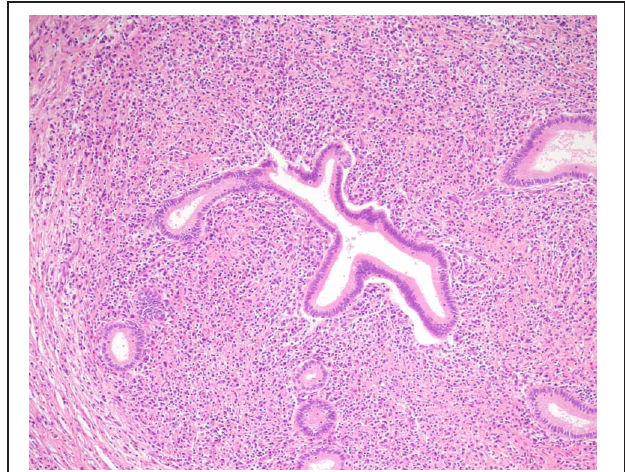
FIGURE 1 | Histological feature of the pancreas of Type-1